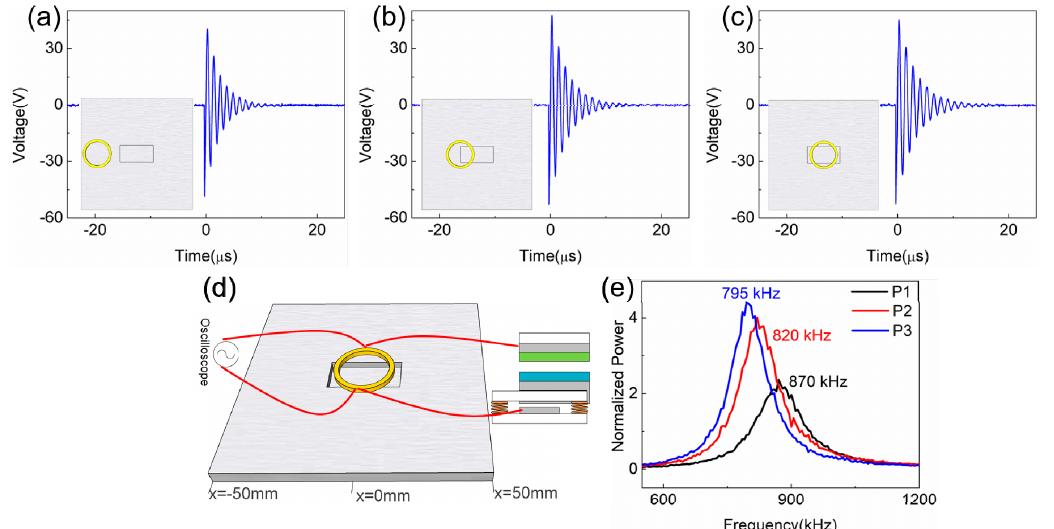
Figure 4. Comparison of resonant signals collected from the coil when it is away from the defect (30 mm × 15 mm × 3 mm) at P1 ( a ), half at P2 ( b ), and on top of the defect at P3 ( c ). ( d ) Experiment configuration of non-destructive defect detection using microswitch integrated TENG and the coil inductor. ( e ) is the comparison of the FFT spectra for three cases, showing the variation of the resonant frequency at P1, P2, and P3.